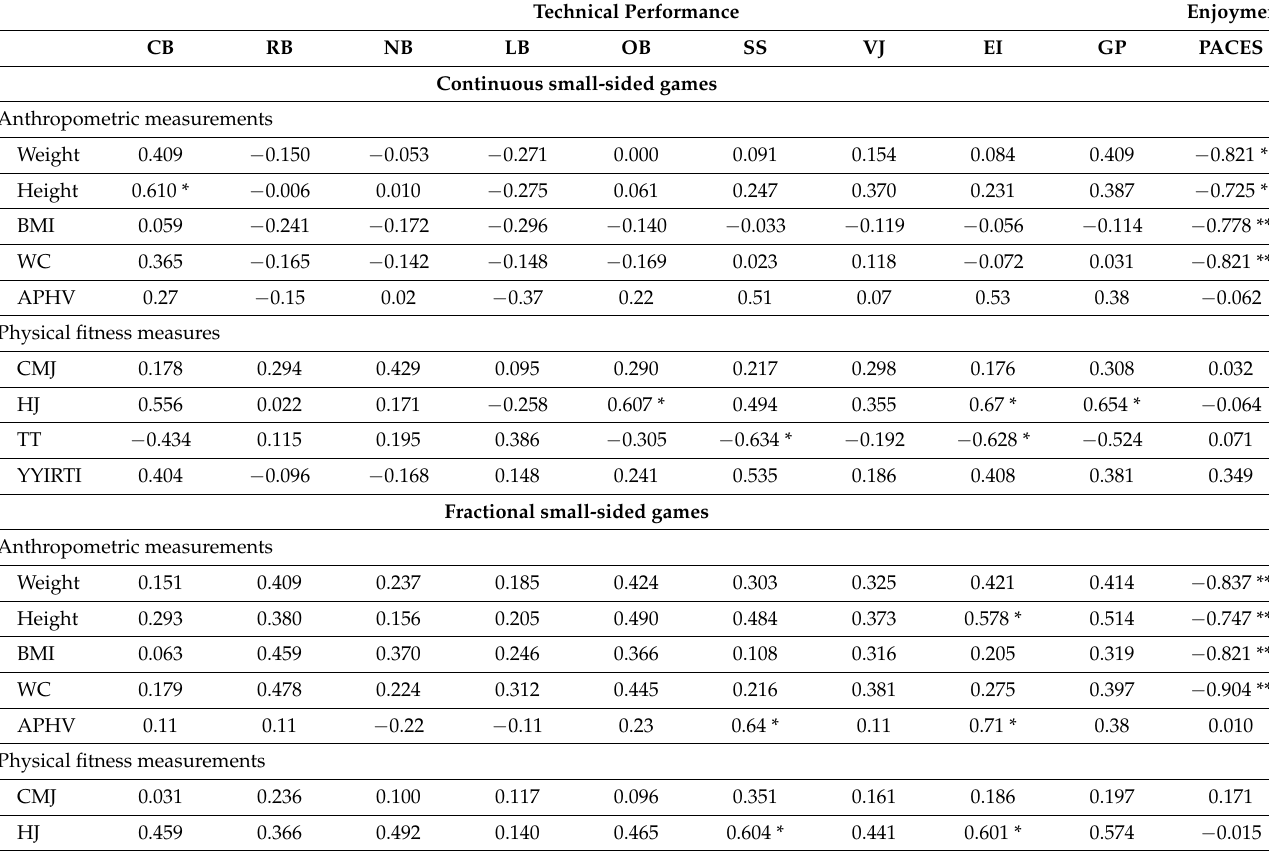
Table 3. Relationship between anthropometric and physical fitness measures with technical perfor- mance measures and enjoyment during small-sided soccer